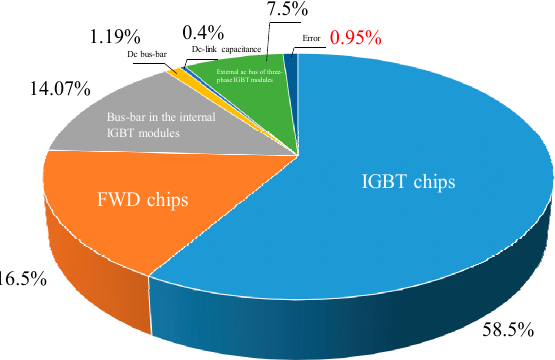
Figure 14. Power loss distribution of the inverter losses.